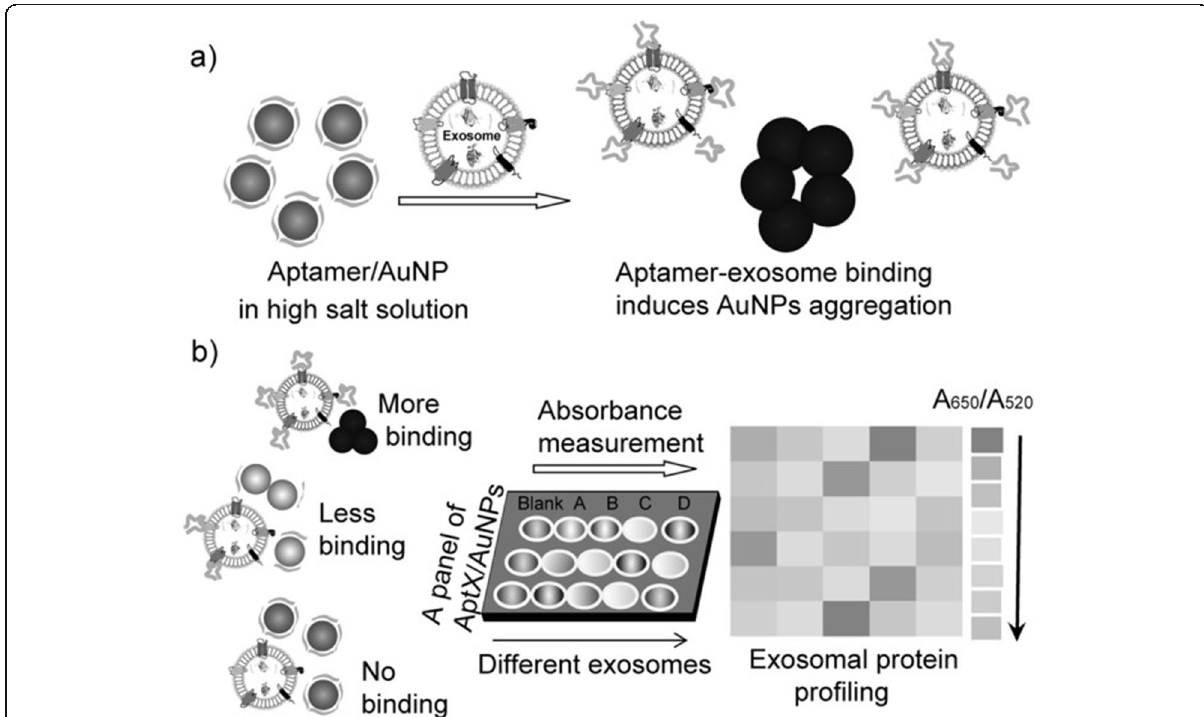
Fig. 9 The aptamer/AuNP complex used for molecular profiling of exosomes [172].© 2017 Wiley-VCH Verlag GmbH & Co. KGaA,